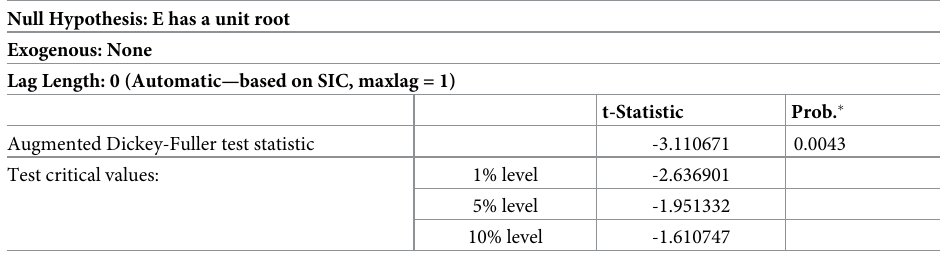
Table 4. Johansen Cointegration test